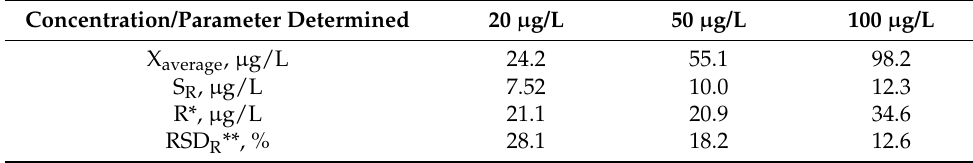
Table 3. Intermediate precision test